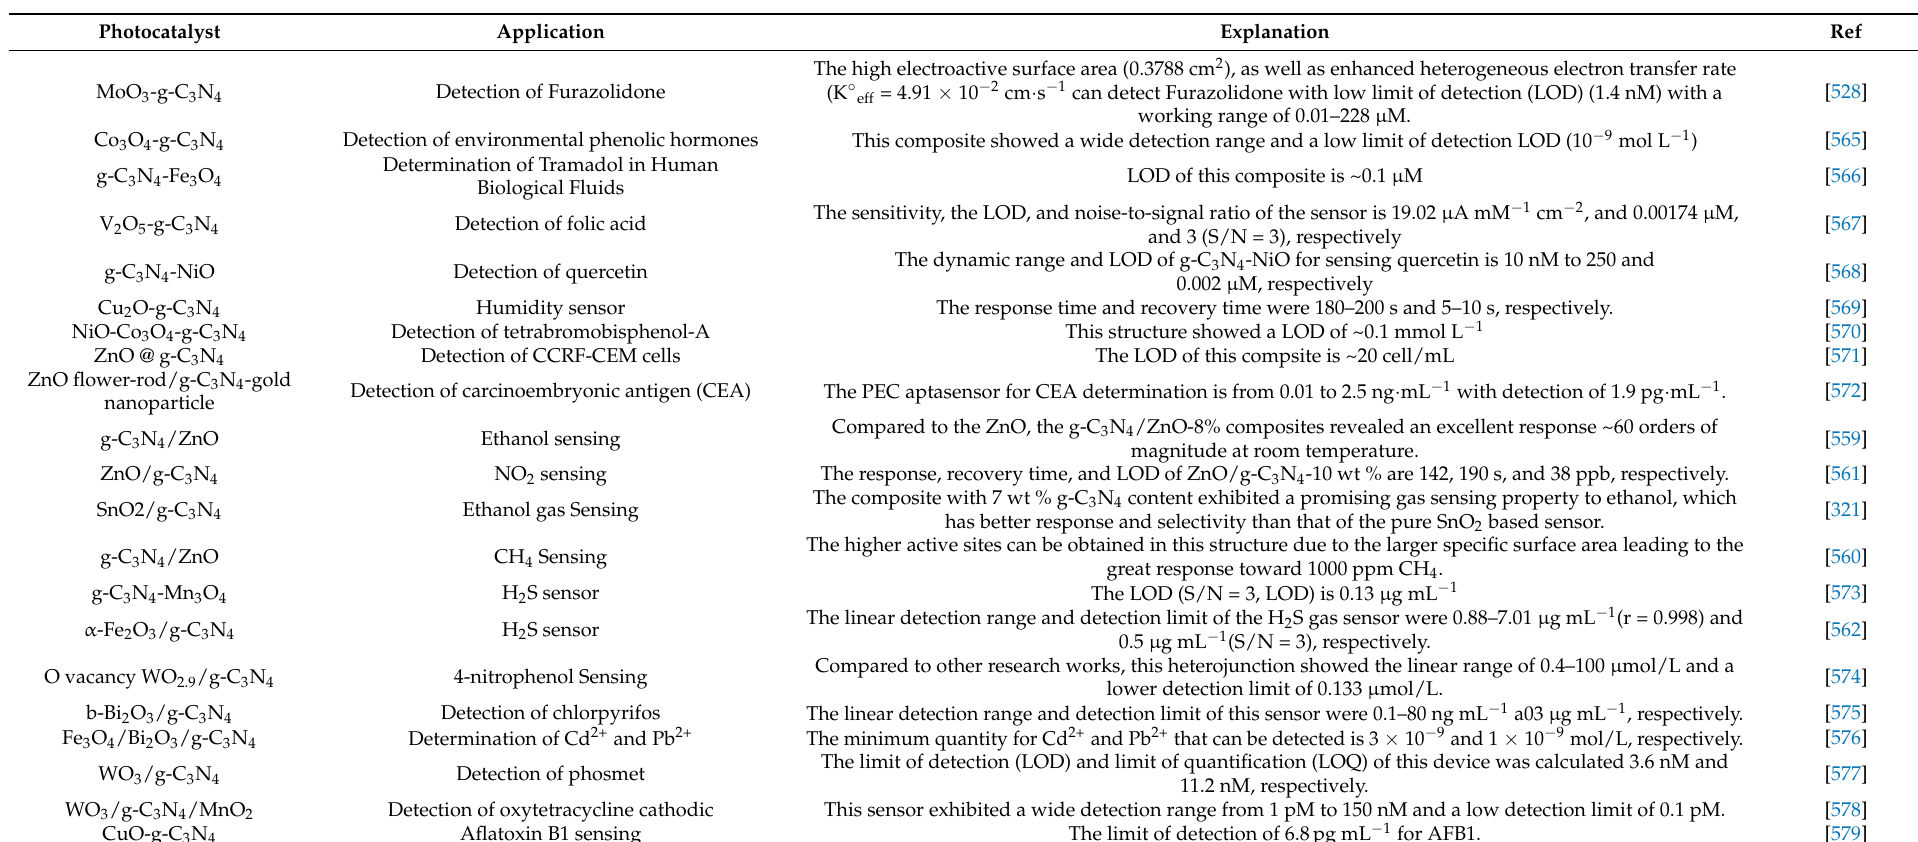
Table 5. The list of applications of g-C 3 N 4 –metal oxide heterojunction used for